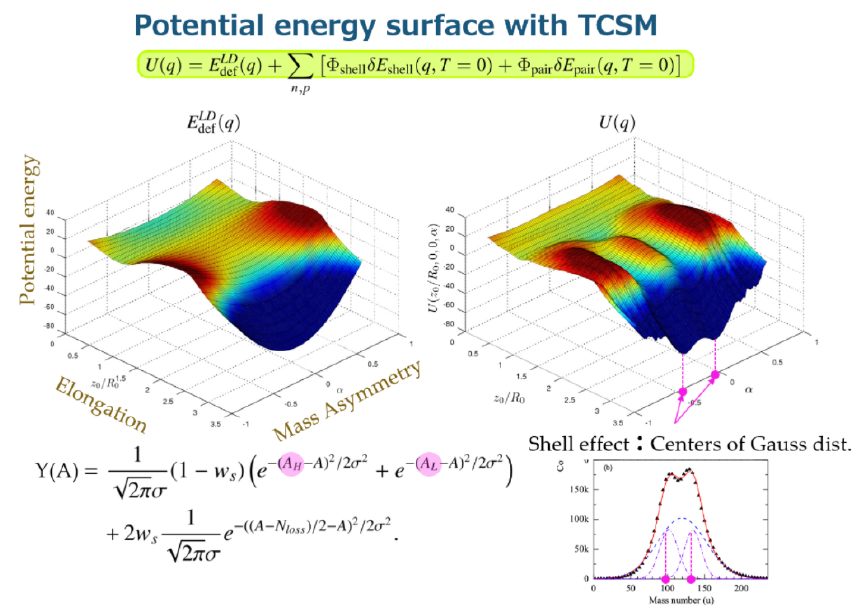
Figure 1. Schematic view of how to construct the mass yield from the potential surface of two center shell model (TCSM). Mass numbers A H and A L in the mass yield Y ( A ) correspond to the valleys of the potential energy surface with respect to the fission fragment mass